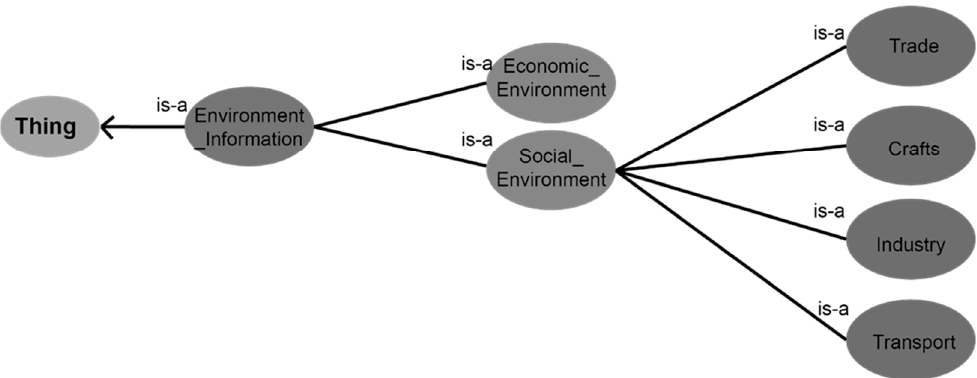
Figure 3. Environment_information concept.